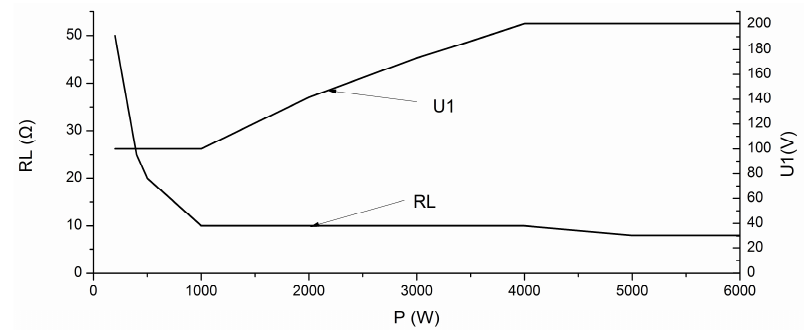
Figure 6. Control model of load adaptive control strategy.